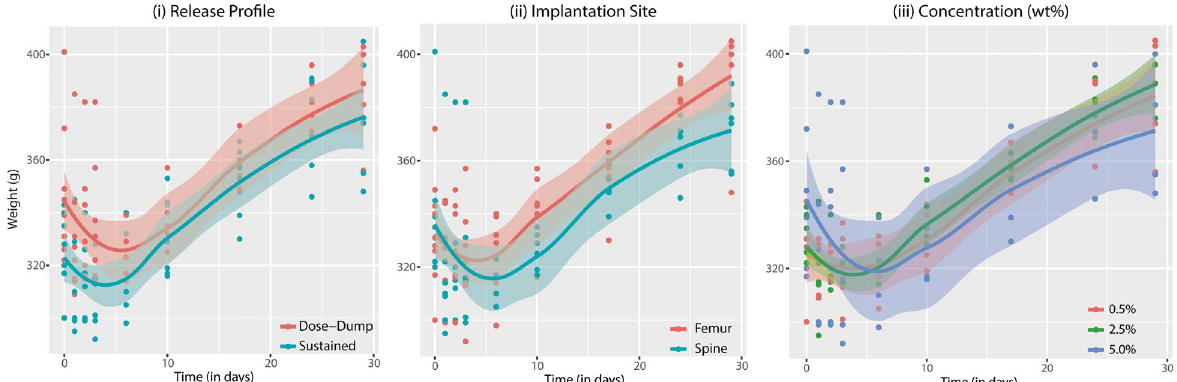
Fig. 4 Body weight changes in rats undergoing surgery and infusion of bupivacaine. Median body weight and interquartile range (IQR) are shown. (i) Weight changes over time in rats receiving bupivacaine infusion in a dose‑dump or sustained fashion. (ii) Weight changes over time in rats undergoing spinal or femoral catheter implantation and bupivacaine infusion. (iii) Weight changes over time in rats receiving infusion of 0.5%, 2.5%, or 5.0% bupivacaine HCl solution. T 0 marks preoperative =